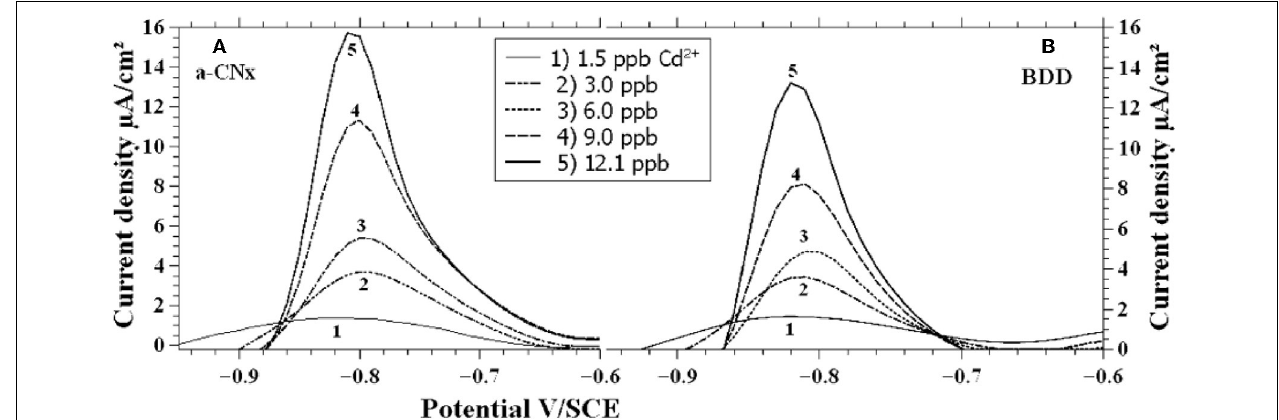
FIGURE 2 | Voltammograms for a-CNx (A) and BDD (B) in solutions containing different Cd 2 + concentrations. Reprinted with permission from Seck et al. (2012). Copyright 2012